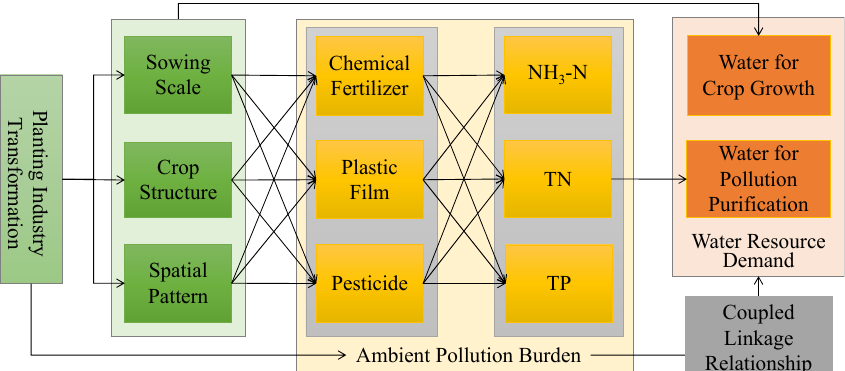
Figure 1. Evaluation framework of the relationship between planting industry transformation with resource and environment pressures.